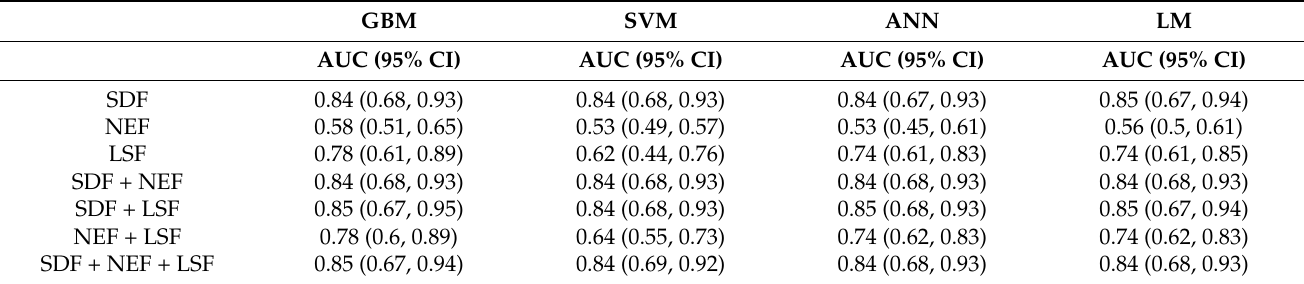
Table 3. Pooled area under the curve (AUC) estimates and 95% CI for classifying cognitive function classes. Support vector machine (SVM), artificial neural network (ANN), gradient boosting machine (GBM), and linear models (LM) were used for training. Different combinations of sociodemographic (SDF), neighbourhood environment (NEF), and lifestyle (LSF) factors were used in the